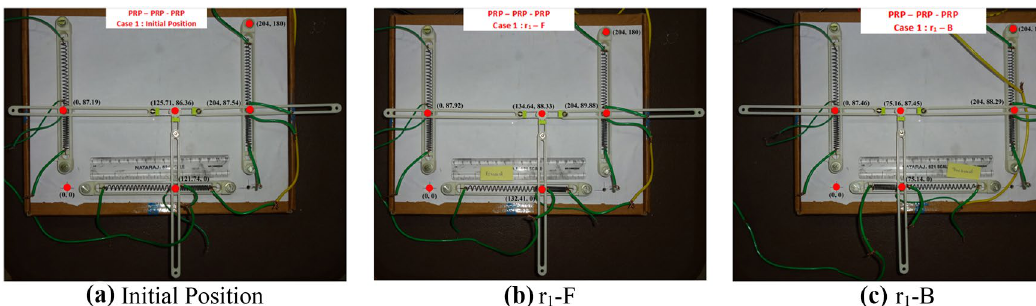
Fig. 13 Actuation of SMA springs of C8 manipulator (Condition 1)